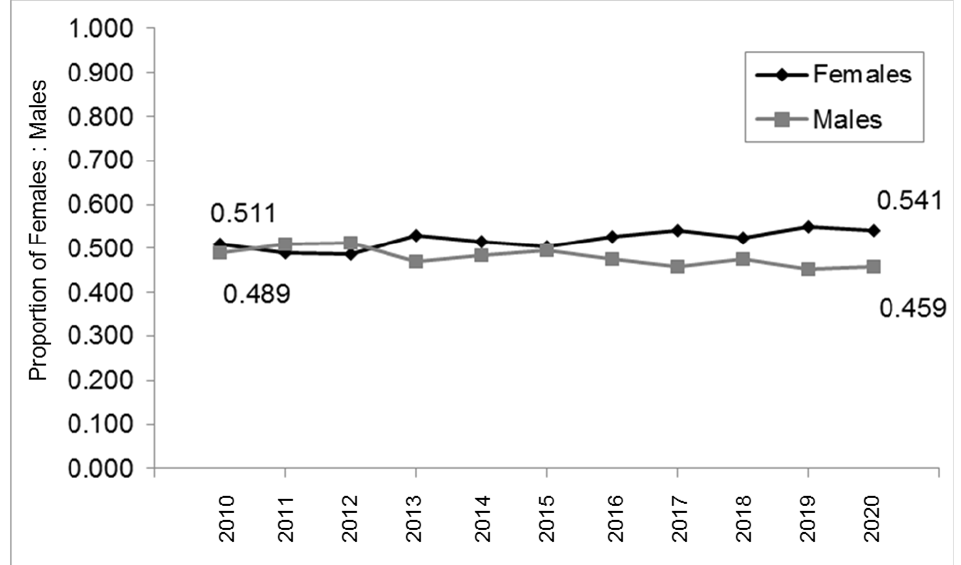
Figure 1. Proportion of males and females within the patient population over time. Plotting the proportion over time demonstrated relative stability among females (52%) and males (48%) between 2010 and 2020.